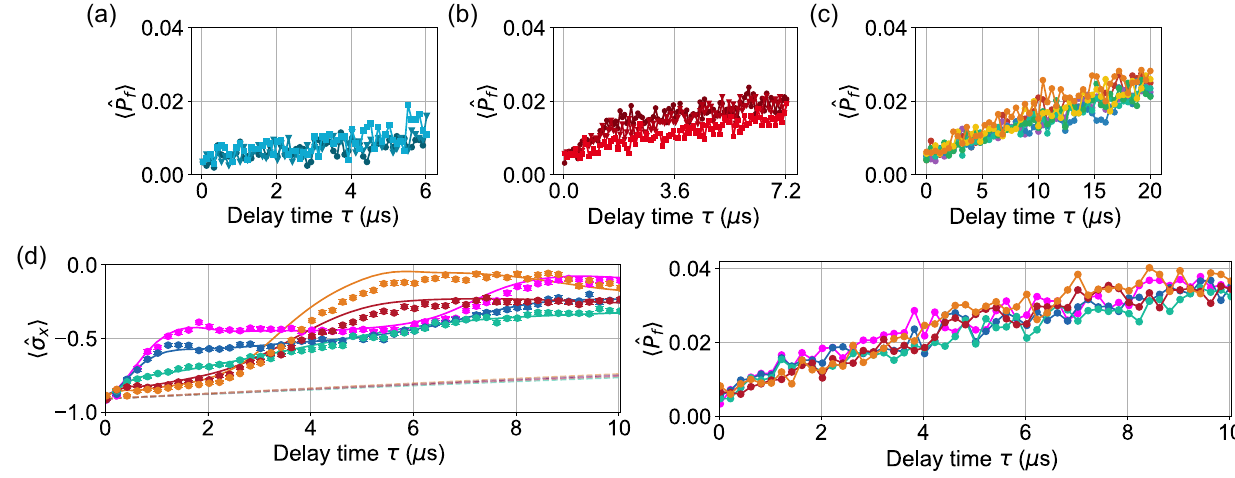
FIG. 12. Extended data and leakage statistics. (a) – (c) Probability of leaking out of the qubit subspace to j f i for the data presented in Figs. 2(b), 2(c), and 10, respectively. (d) The same dataset as appears in Fig. 4(a) (left), but including two additional initial states with = 2 i (blue) and j 3 α (red), with the associated leakage probabilities (right). All of the leakage probabilities are j α 0 i ¼ j α g = 2 i g a a a equivalent to the percentage of data that is postselected away for the rest of the data in the paper, which is always less than 5%.